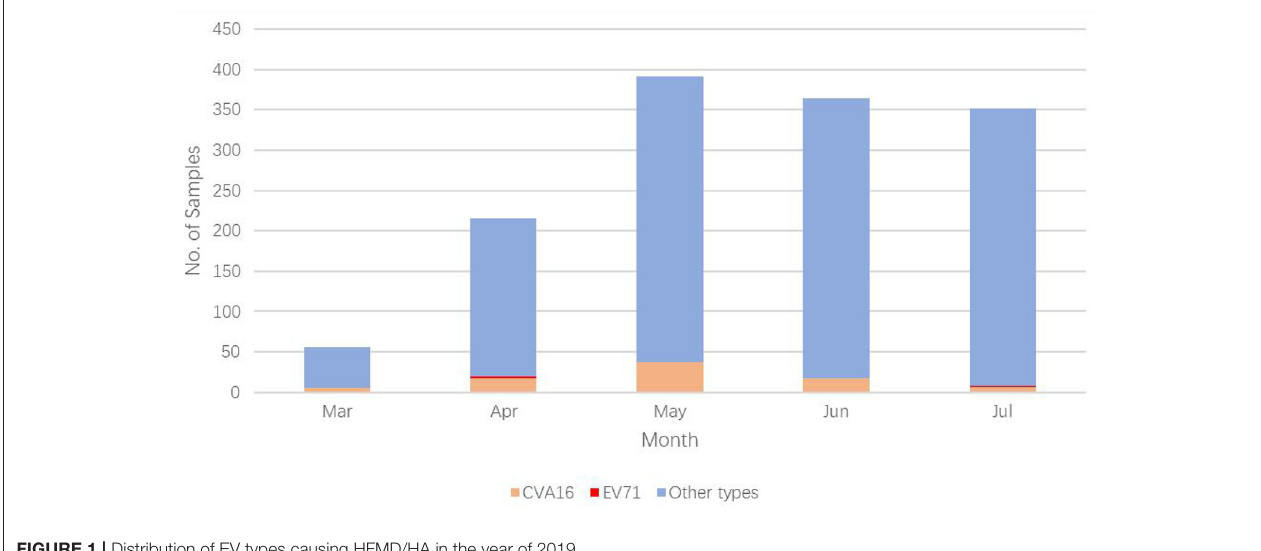
FIGURE 1 | Distribution of EV types causing HFMD/HA in the year of 2019.